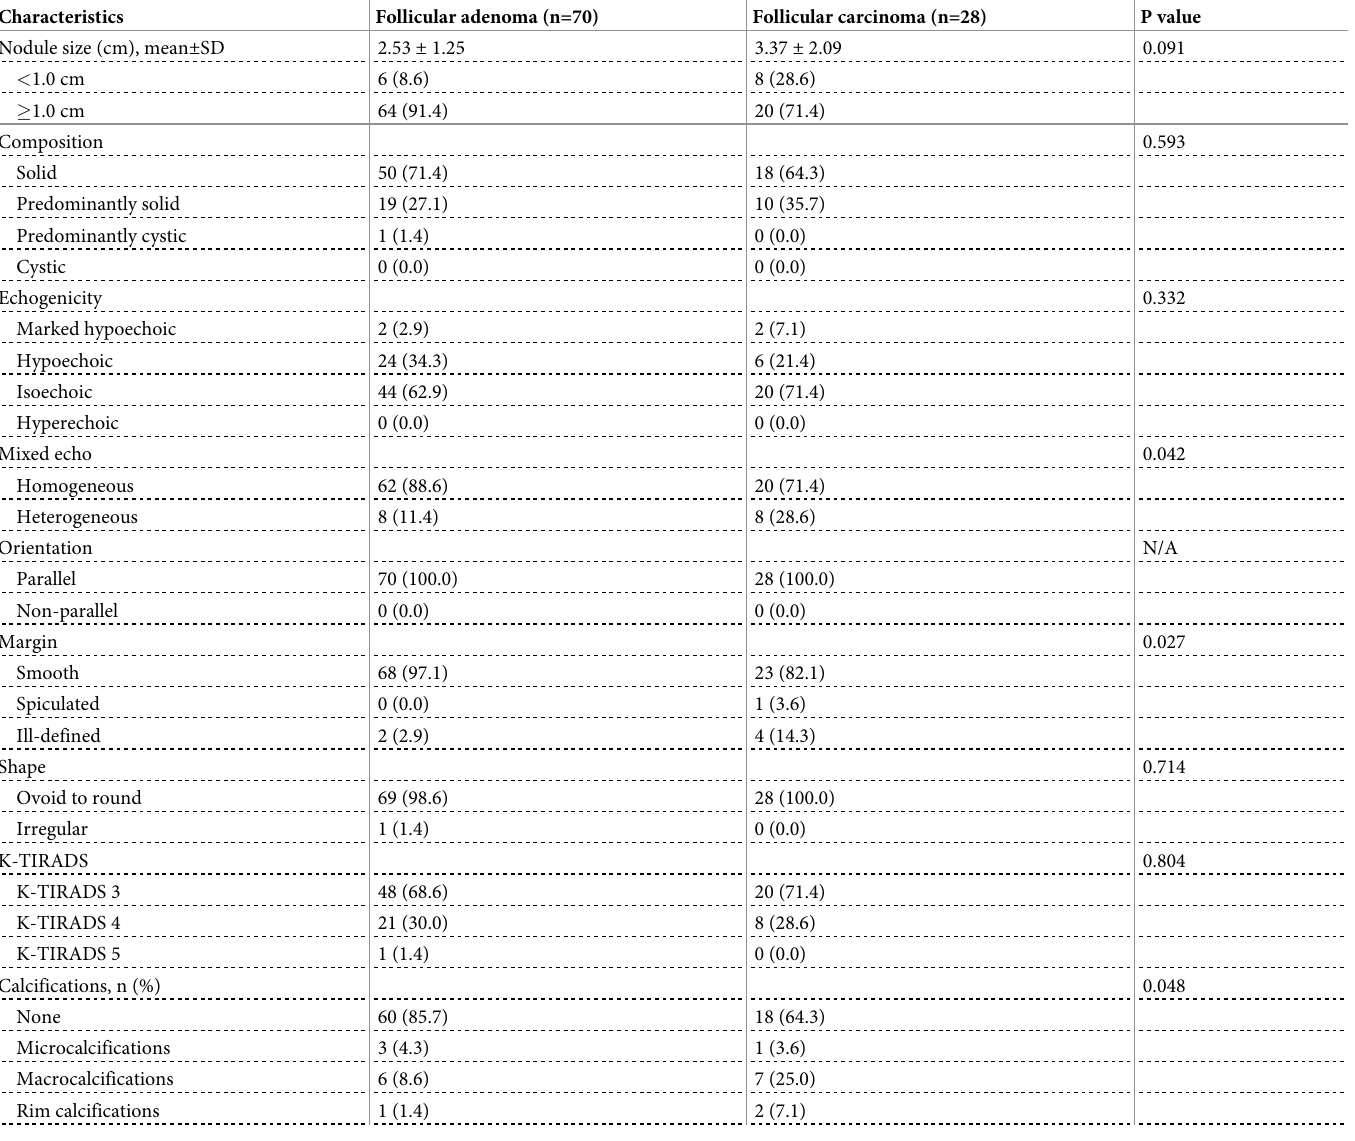
Table 3. US findings correlated with the final diagnoses of thyroid